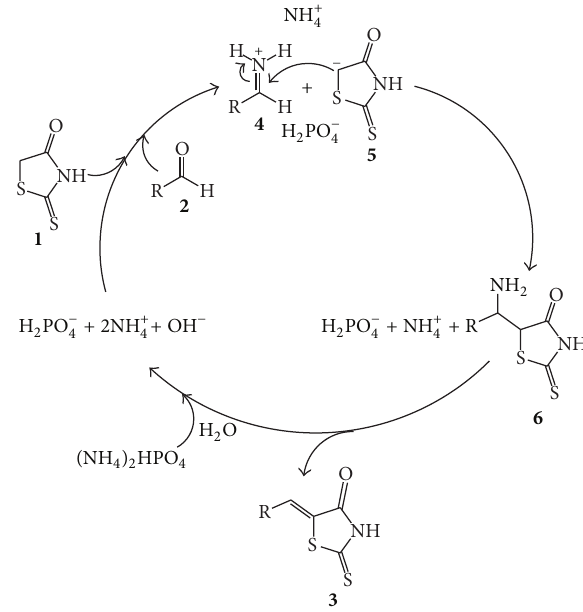
Scheme 2: Plausible mechanism for the synthesis of 5-aryliden- erhodanines catalyzed by diammonium hydrogen